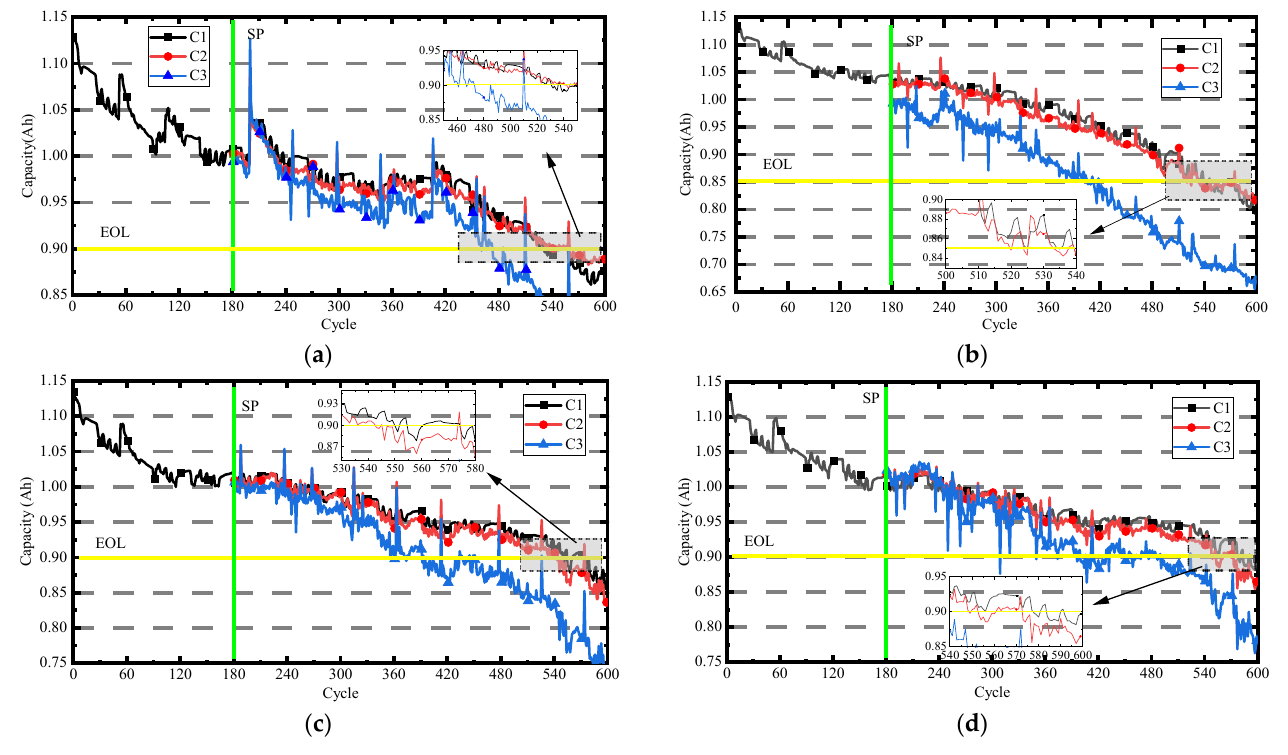
Figure 9. Long–term prediction experimental results curve. ( a ) CS2–35, SP = 180; ( b ) CS2–36, SP = 180; ( c ) CS2–37, SP = 180; ( d ) CS2–38, SP = 180. Table 6. Long–term prediction experimental error